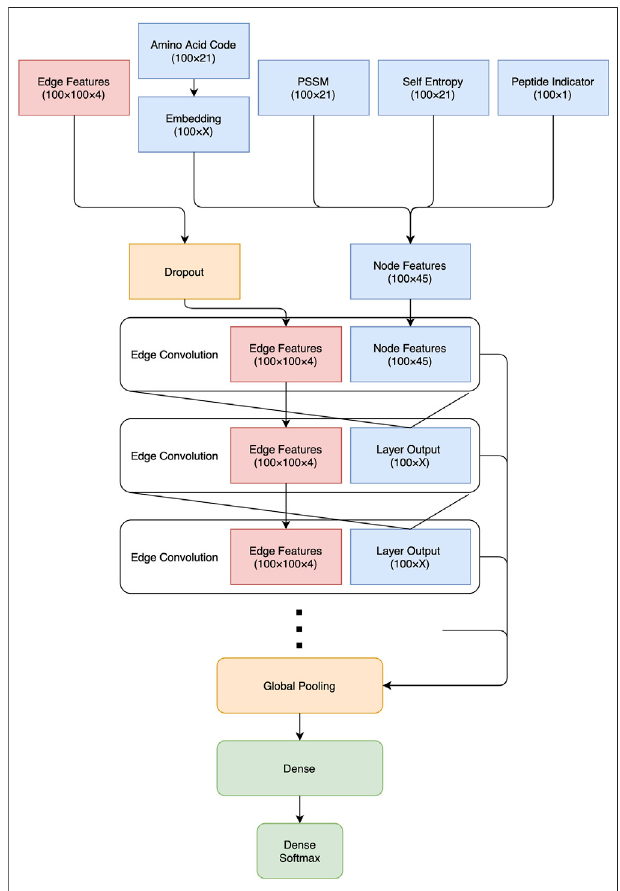
FIGURE 1 | The basic architecture of the InterPepRank networks. Note that the output from the Edge Convolution and Embedding layers have been denoted as X, since different values were sampled. Throughout the net, the ReLU activation function is applied after each